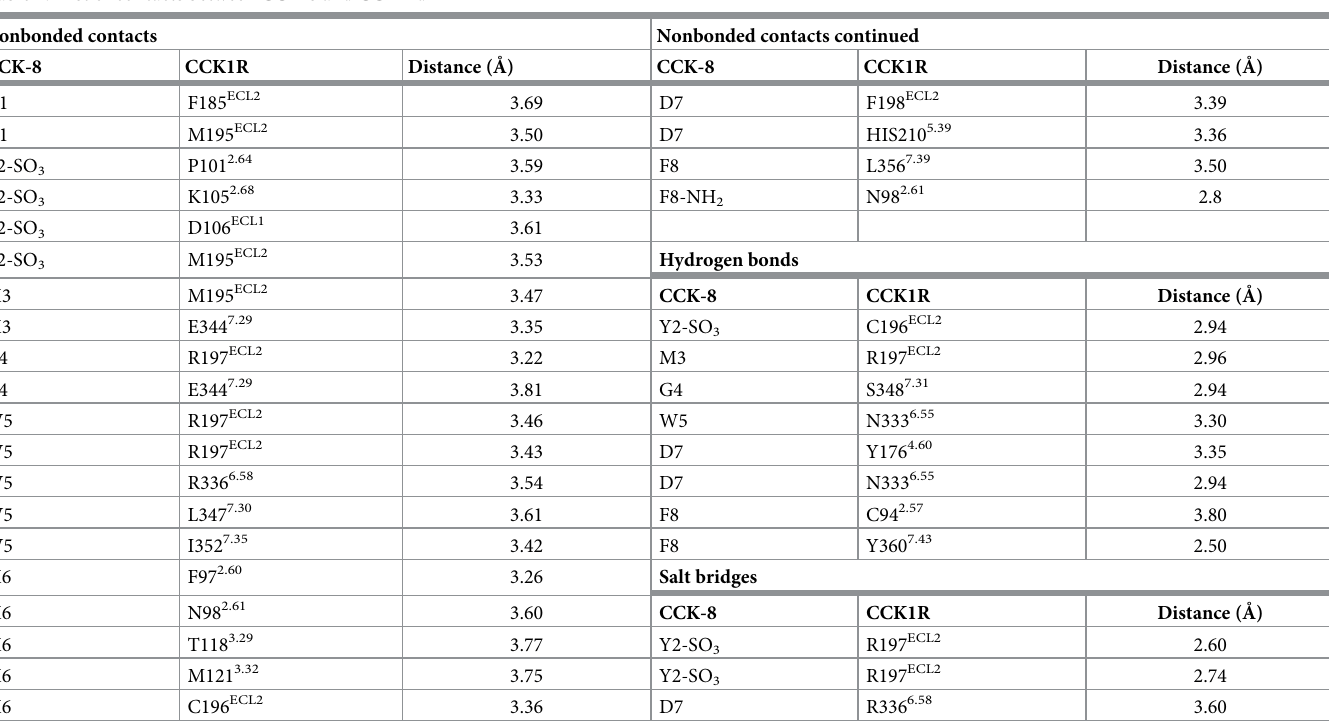
Table 1. List of contacts between CCK-8 and CCK1R. Nonbonded